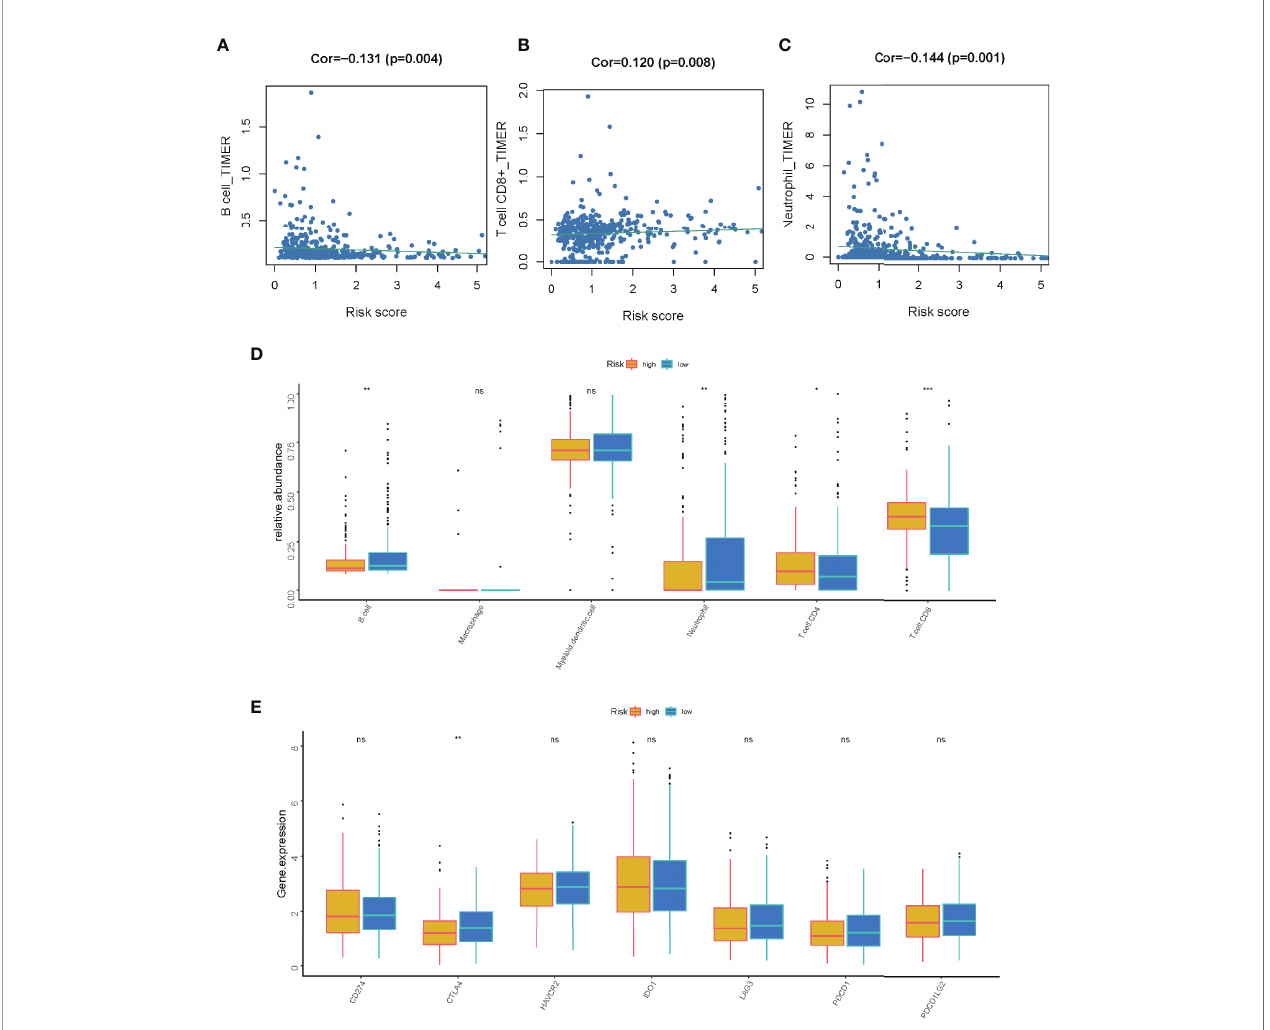
FIGURE 8 | The correlation between the LMR-lncRNA signature and ICB molecules and TIICs determined using TIMER fi ndings. (A – C) Relationship between the signature and the B cell (A) , CD8+ T cell (B) , or neutrophil (C) Spearman correlation. (D) The expression of CD274 , CTLA-4 , HAVCR2 , IDO1 , LAG-3 , PDCD1 , and PDCD1LG2 were compared between low- and high-risk groups. (E) Signi fi cant and positive correlation between the LMR-lncRNA signature and the ICB receptor CTLA-4. ns, not signi fi cant; *P < 0.05; **P < 0.01; ***P <